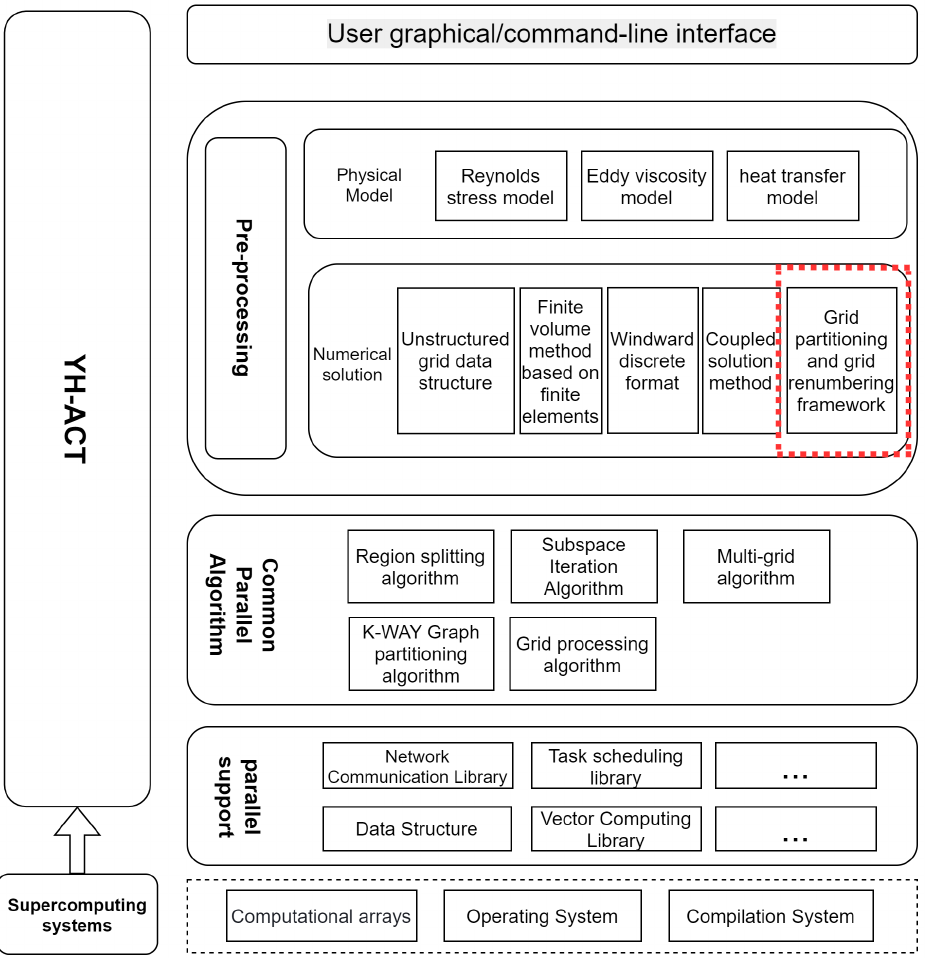
Figure 1. Overall framework of YHACT, framework after integration of meshing and mesh renum- bering functions. Red boxes indicate new modules for